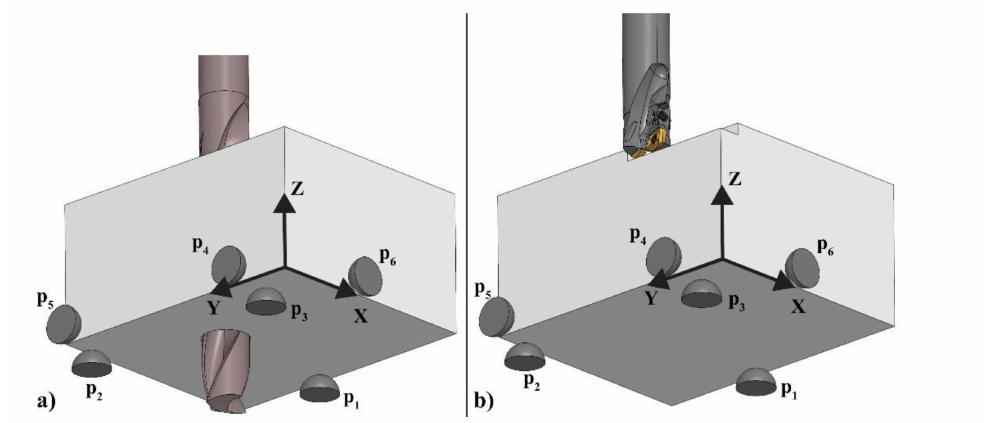
Figure 1. The 3-2-1 locator scheme for: ( a ) drilling; ( b )